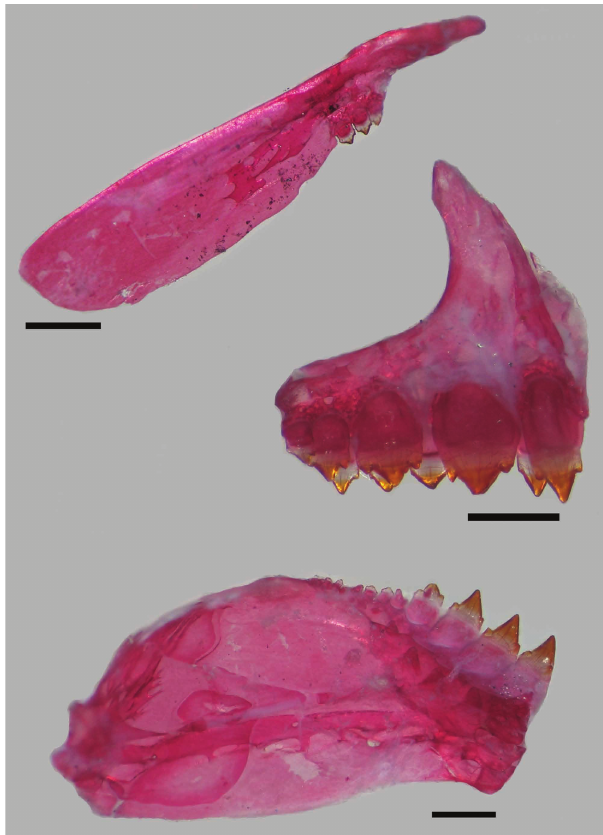
Fig. 2. Astyanax bagual , UFRGS 17834, 68.4 mm SL, paratype. Upper and lower jaws left side, medial